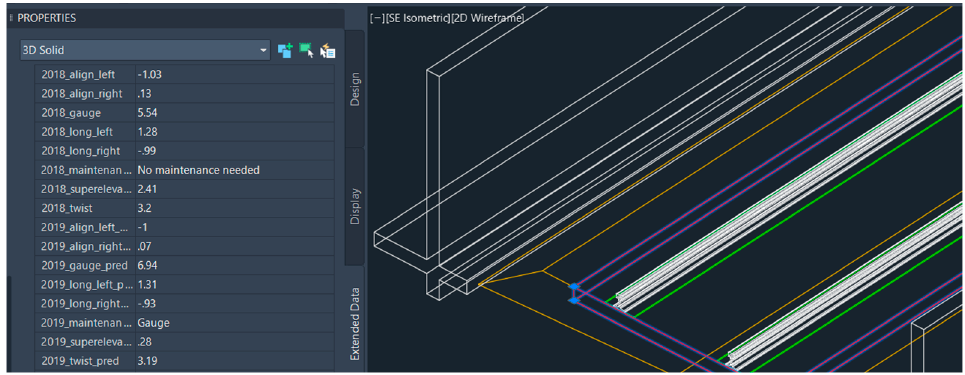
Figure 15. Information integrated into the BIM model.